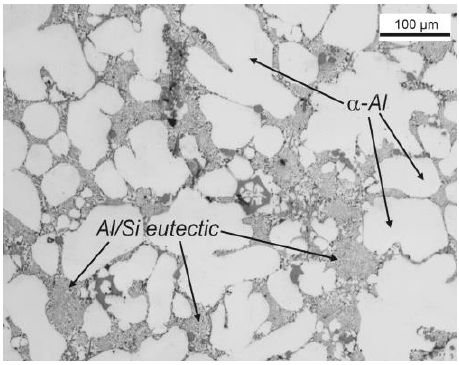
Figure 1. Microstructure of as-rheocast AlSi9Cu3(Fe) alloy.